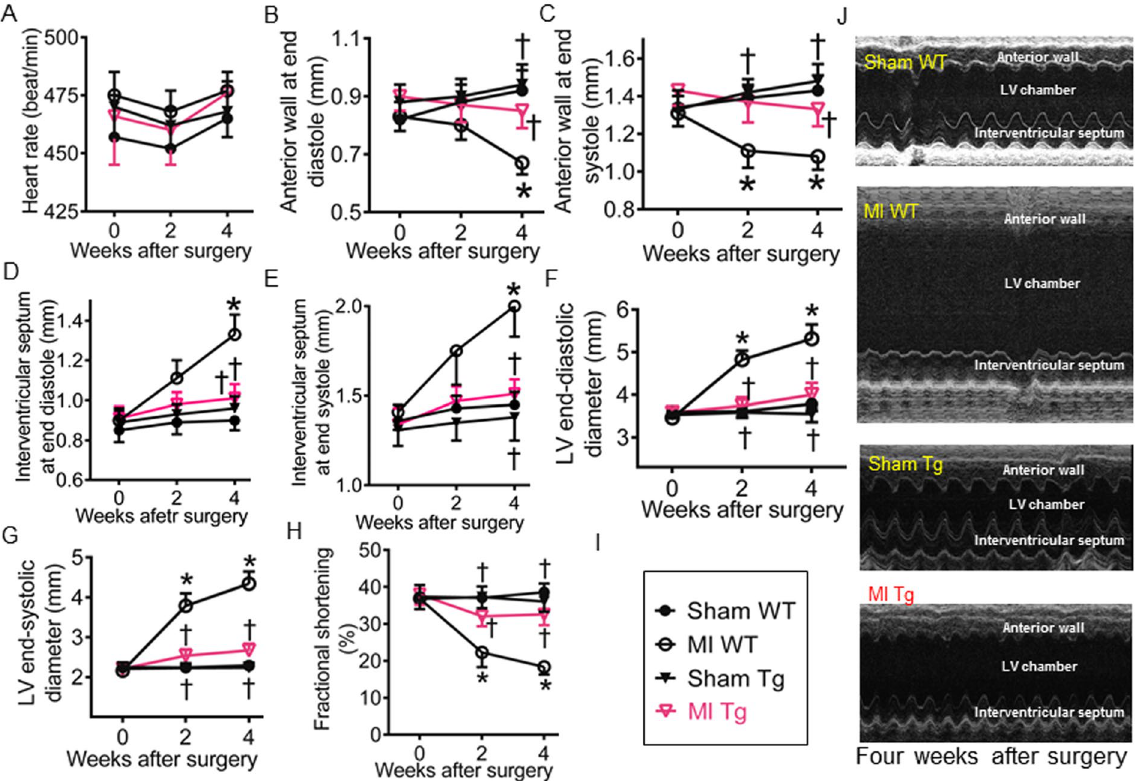
Figure 2. Effects of GTP cyclohydrolase 1 (GCH1) overexpression on cardiac remodeling 4 weeks after myocardial infarction (MI). ( A ) Heart rate; ( B ) The anterior wall thickness of the left ventricle (LV) at end diastole: ( C ) The anterior wall thickness of the LV at end systole; ( D ) The interventricular septum thickness of the LV at end diastole: ( E ) The interventricular septum thickness of the LV at end systole; ( F ) LV end-diastolic diameter; ( G ) LV end-systolic diameter; ( H ) Fractional shortening; ( I ) Figure legend: sham WT (wild-type), MI WT, sham Tg (GCH1 transgene), and MI Tg; ( J ) representative M-mode echocardiograms showing anterior wall, LV chamber, and interventricular septum in the mice 4 weeks after MI. * P < 0.05 versus sham WT groups; † P < 0.05 versus MI WT groups (n = 8–12